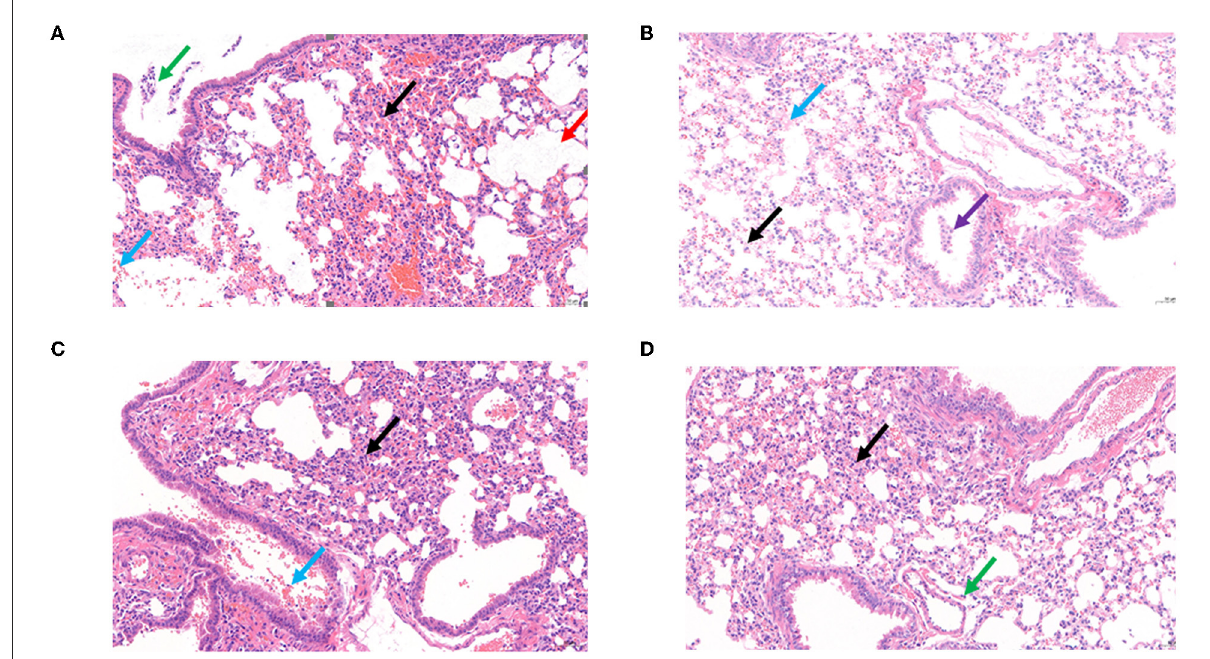
FIGURE8 Histopathological examination of the mouse lungs. (A) Control: The BALB/c mice only infected K. pneumoniae S-2007. (B) Negative: The BALB/c mice without any treatment. (C) The BALB/c mice infected phage BUCT541(2 × 10 7 PFU/each). (D) Treatment BALB/c mice with MOI = 10 of phage BUCT541. (Black arrow: with a small amount of inflammatory cell infiltration; Blue arrow: multifocal hemorrhage is visible in the tissue; Purple arrow: multiple perivascular edema with a small amount of lymphocytic infiltration; Red arrow: multiple alveolar dilatation is visible in the tissue; Green arrow: a small number of lymphocytes are visible in a few